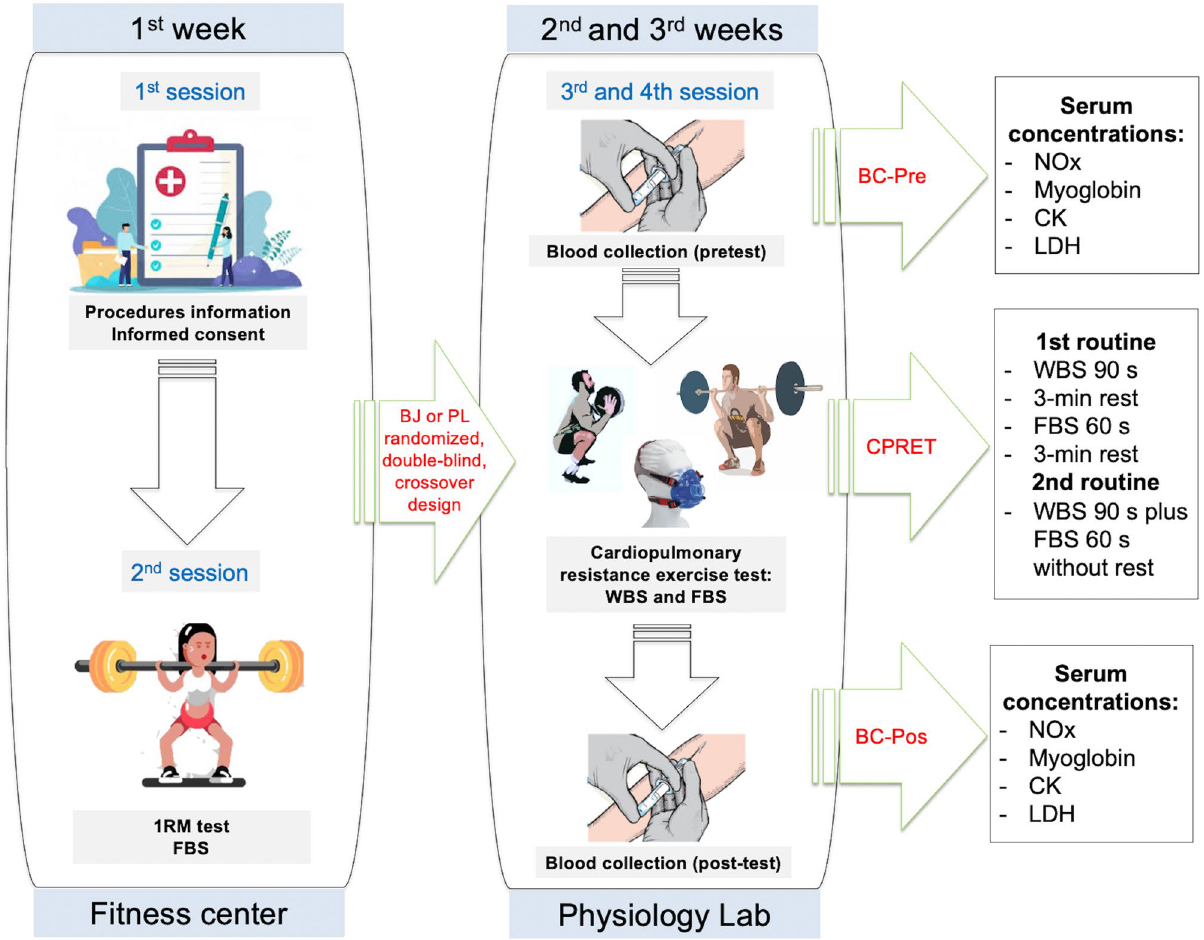
Figure 2. Procedures. 1RM, one-repetition maximum; BC, blood collection; BJ, beetroot juice; CK, creatin kinase; CPRET, cardiopulmonary resistance exercise test; FBS, full back squat; LDH, Lactate dehydrogenase; NOx, nitrate plus nitrite; PL, placebo; WBS, wall ball